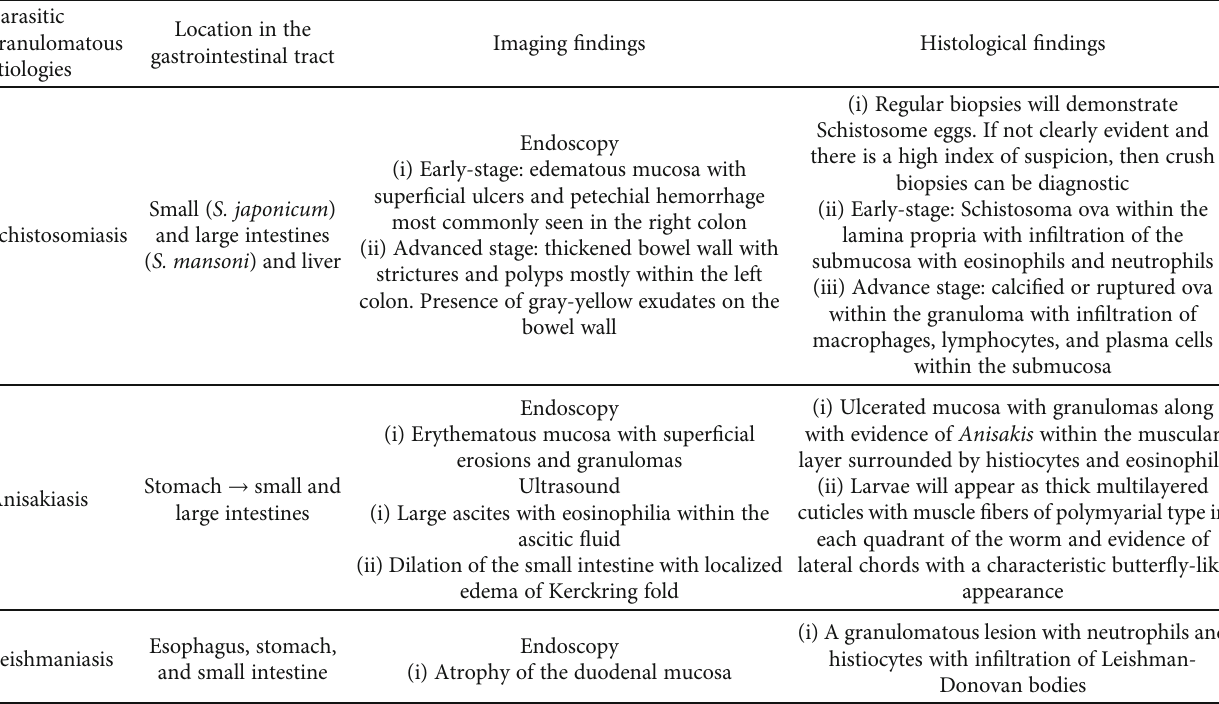
Table 3: Comparison of imaging and microscopic fi ndings together with regions of the gastrointestinal tract a ff ected by parasitic causes of granulomatous